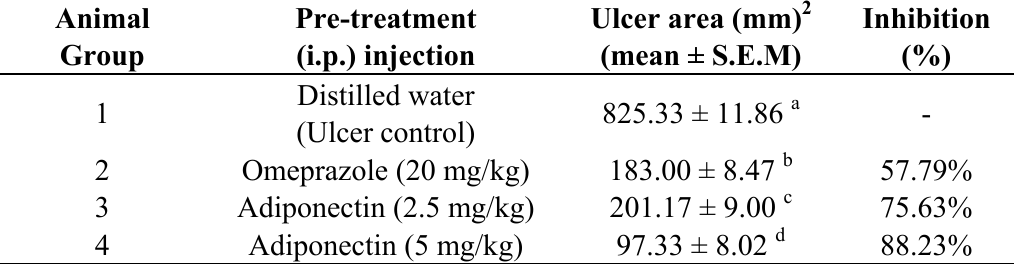
Table 8. Observed ulcer area and inhibition percentage in